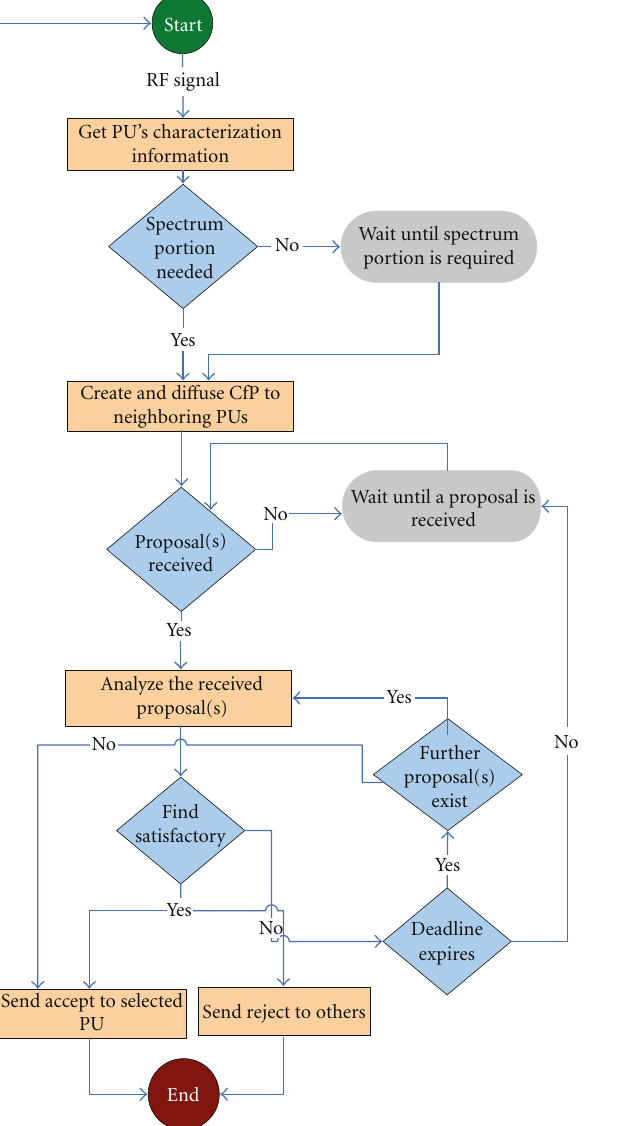
Figure 3: Secondary user’s behavior.